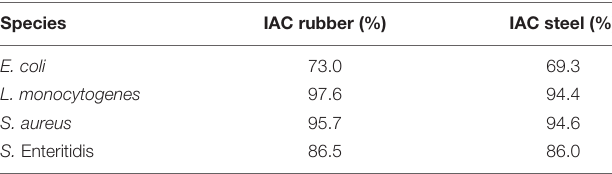
TABLE 2 | Initial adhesion coefficient (IAC) of tested bacterial species. Species IAC rubber